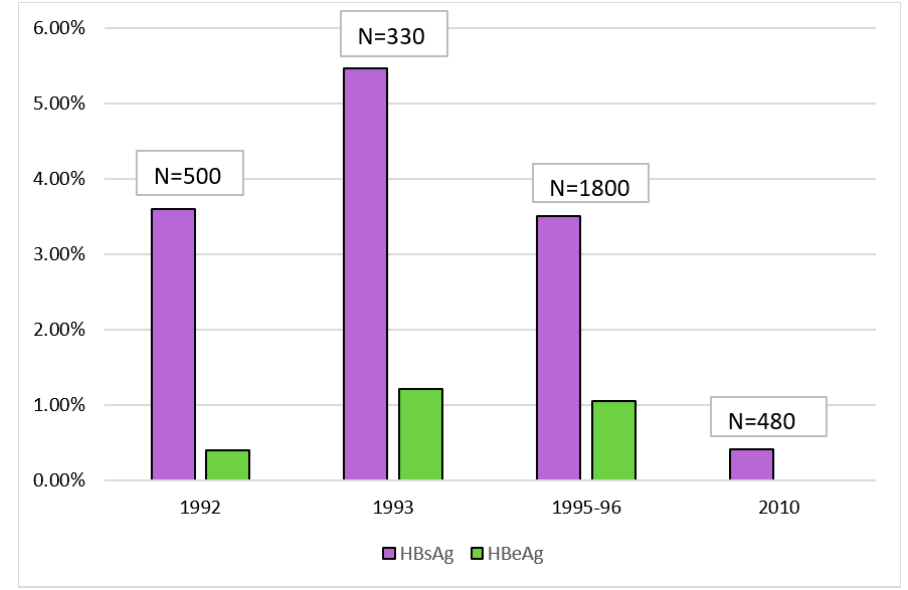
Figure 5. Prevalence of HBV biomarkers among pregnant women and new mothers in Bangladesh. Genes 2018 , 9 , x FOR PEER REVIEW